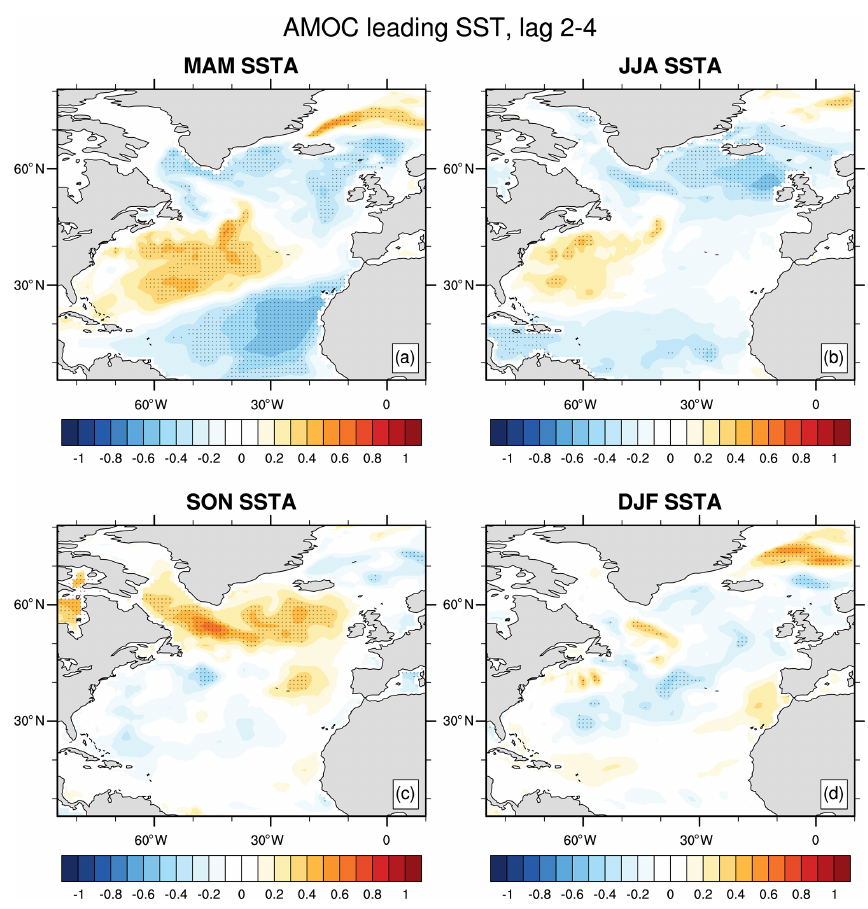
Figure 5. The 2–4-month lagged correlations between the SSTAs over the North Atlantic and the AMOC at 26 ◦ N during 1982–2014, with the AMOC leading ( a–d , as labelled) in the assimilation experiment. For example, in (a) the AMOC in January is correlated to spring SSTAs. The stippling represents significant correlations at the 95% confidence level, calculated from 1000 bootstrap